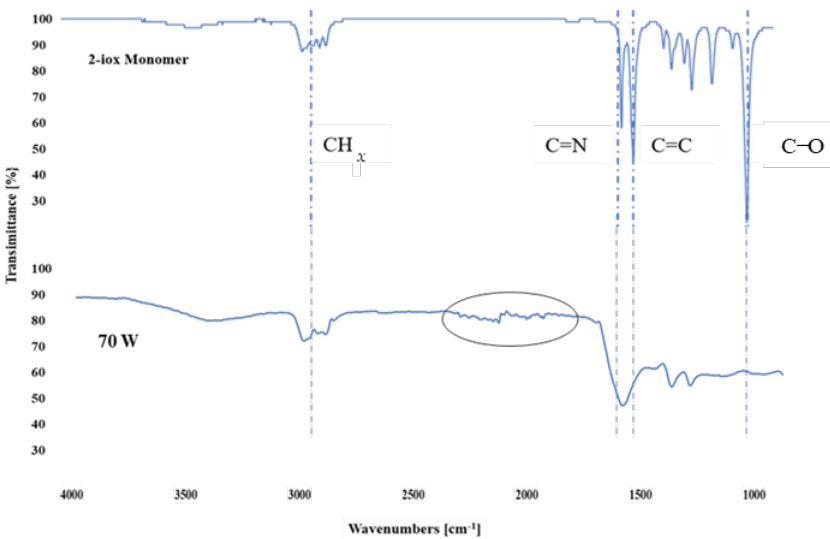
Figure 4. ATR-FTIR spectra of the monomer and 70 W PPOL. The peak at 3000 cm −1 is relative to CH x ; at 1662 cm −1 , the C=N peak is identifiable; at 1630 cm −1 , the signal is relative to the C=C. The peak of C–O is no longer identifiable.